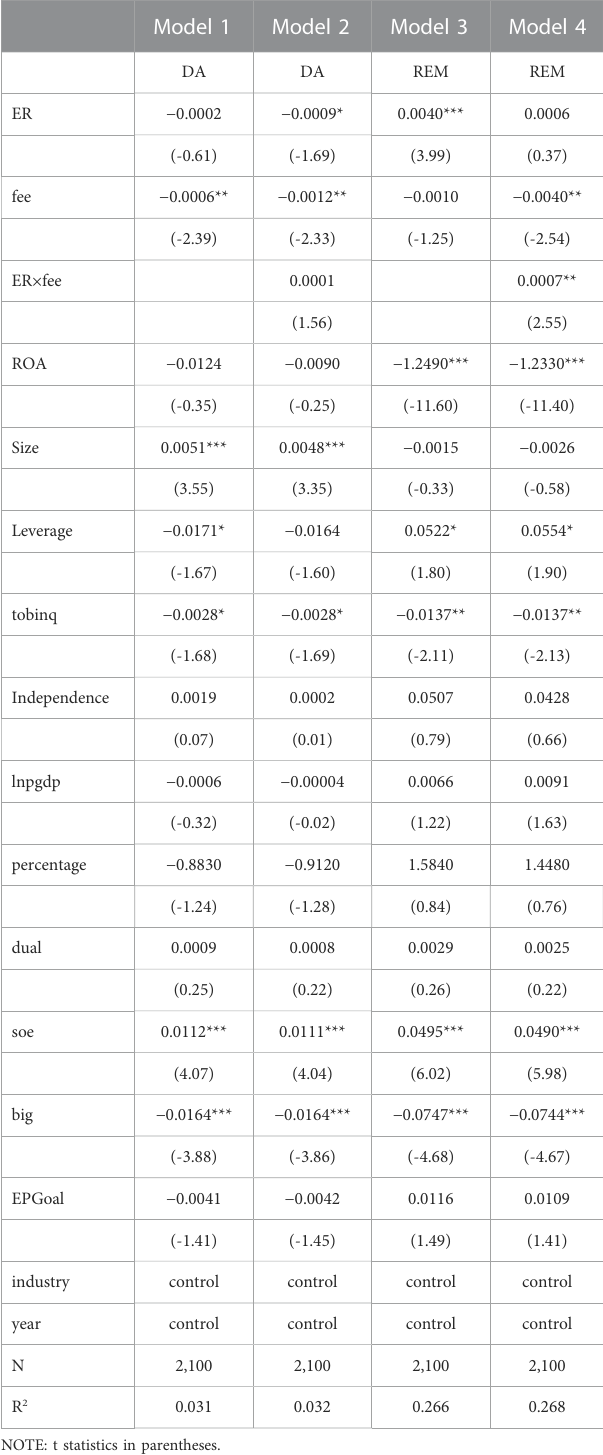
TABLE 4 Results of full sample